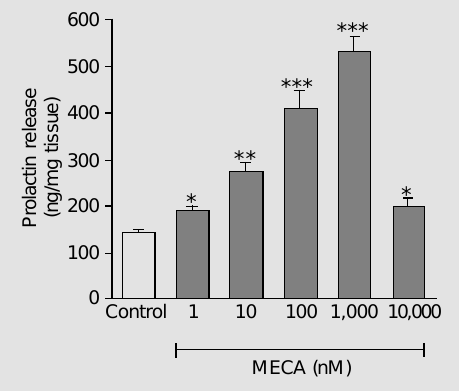
Figure 1. Effect of 5-N-methyl- carboxamidoadenosine (MECA) on basal prolactin secretion. Data are reported as means ± SEM (N = 5). *P<0.05, **P<0.01, ***P<0.001 com- pared to control (Student t